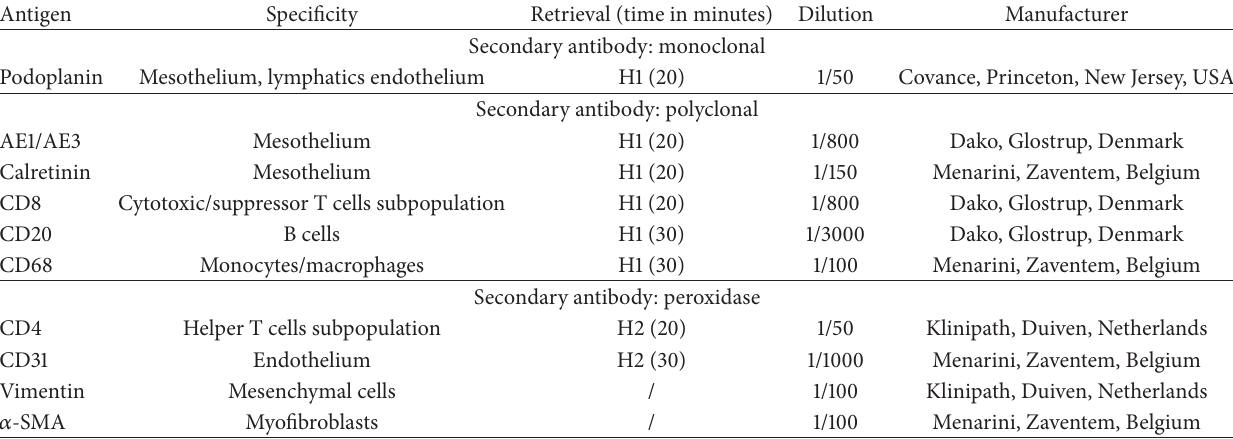
Table 1: Details of immunohistochemistry studies performed on peritoneal tissue biopsies (primary antibodies and corresponding cells specificity, retrieval processes, dilution, and type of secondary